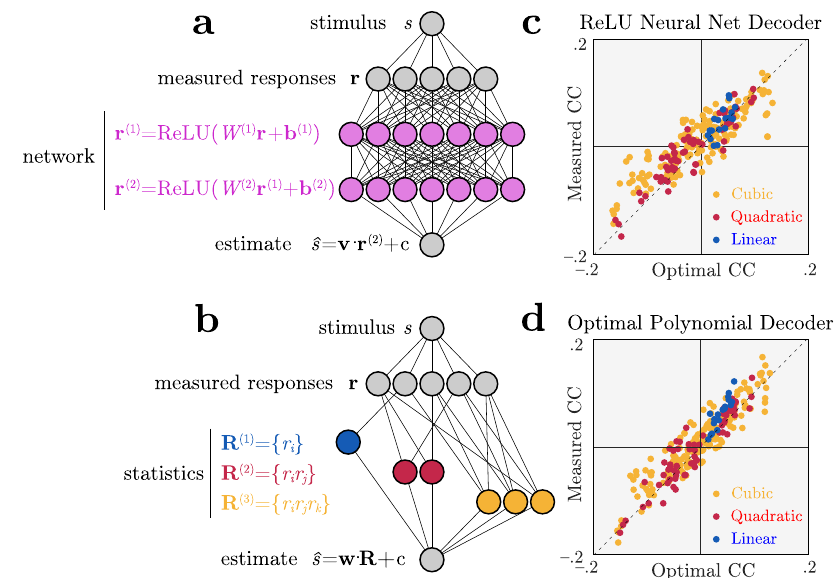
Fig. 5 Identifying optimal nonlinear decoding by a generic neural network using nonlinear choice correlations. Neural responses r are constructed to encode stimulus information in polynomial suf fi cient statistics up to cubic order (see the “ Methods ” section Eq. (13)). These responses are decoded by an arti fi cial nonlinear neural network or polynomial nonlinearities, and we evaluate the quality of the decoding using polynomial nonlinearities for both cases. a Architecture of a network that uses ReLU nonlinearities trained to extract the relevant information. b Architecture of a second network that instead uses polynomial nonlinearities to extract the relevant information. c , d Choice correlations based on polynomial statistics show that both networks' computations are consistent with optimal nonlinear decoding (see the “ Methods ” subsection “ Nonlinear choice correlation to analyze an unknown nonlinearity ” ), even though the simulated networks used different implementations to extract the stimulus information. Horizontal axis shows optimal choice correlations (Eq. (7)); vertical axis shows measured choice correlations (Eq.